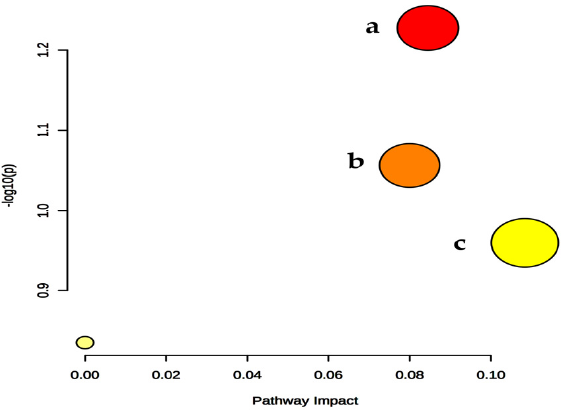
Figure 3. The bubble chart of metabolic pathway analysis. a Arginine biosynthesis; b Galactose metabolism; c Arginine and proline metabolism.